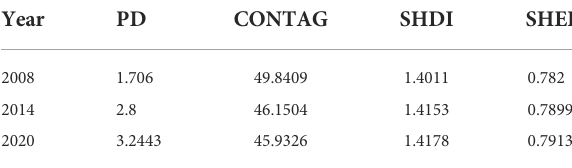
TABLE 6 Landscape pattern index at landscape